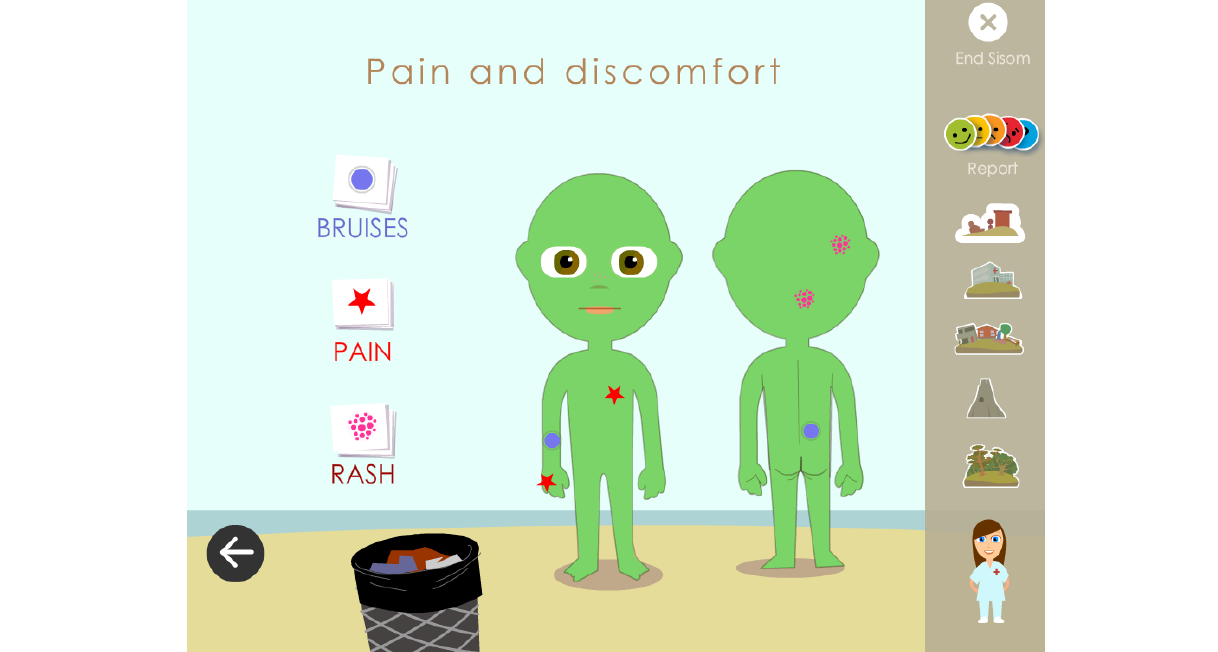
Figure 11. The children appreciated being able to answer by indicating areas of pain, bruises, and rashes on a body